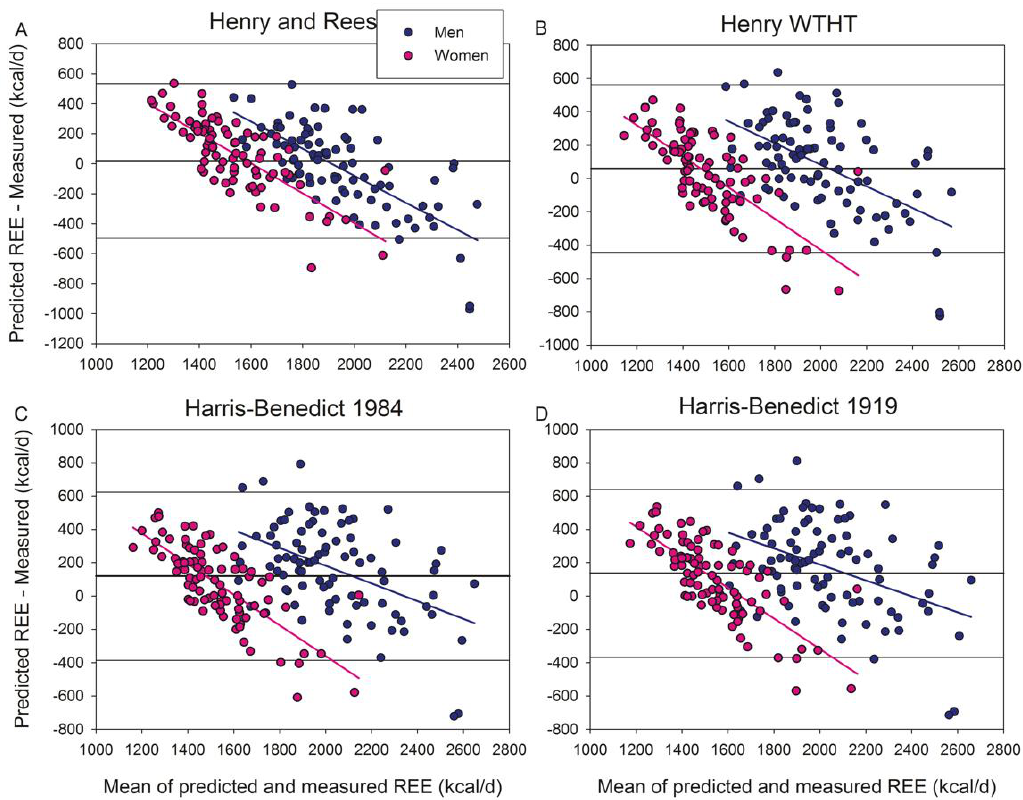
Figure 3. Bland–Altman plots displaying the agreement between measured and predicted REE by the equations of ( A ) Henry and Rees (tropical populations), ( B ) Henry WTHT, ( C ) Harris–Benedict 1984, and ( D ) Harris–Benedict 1919. All these equations did not include obese subjects in their populations. The thick continuous line indicates the mean value of the differences between predicted and measured REE (bias). The thin lines delimit the 95% confidence interval. All the regression lines were statistically significant at p < 0.001, indicating a systematic bias. Note that “Y” and “X” axes have different scales.